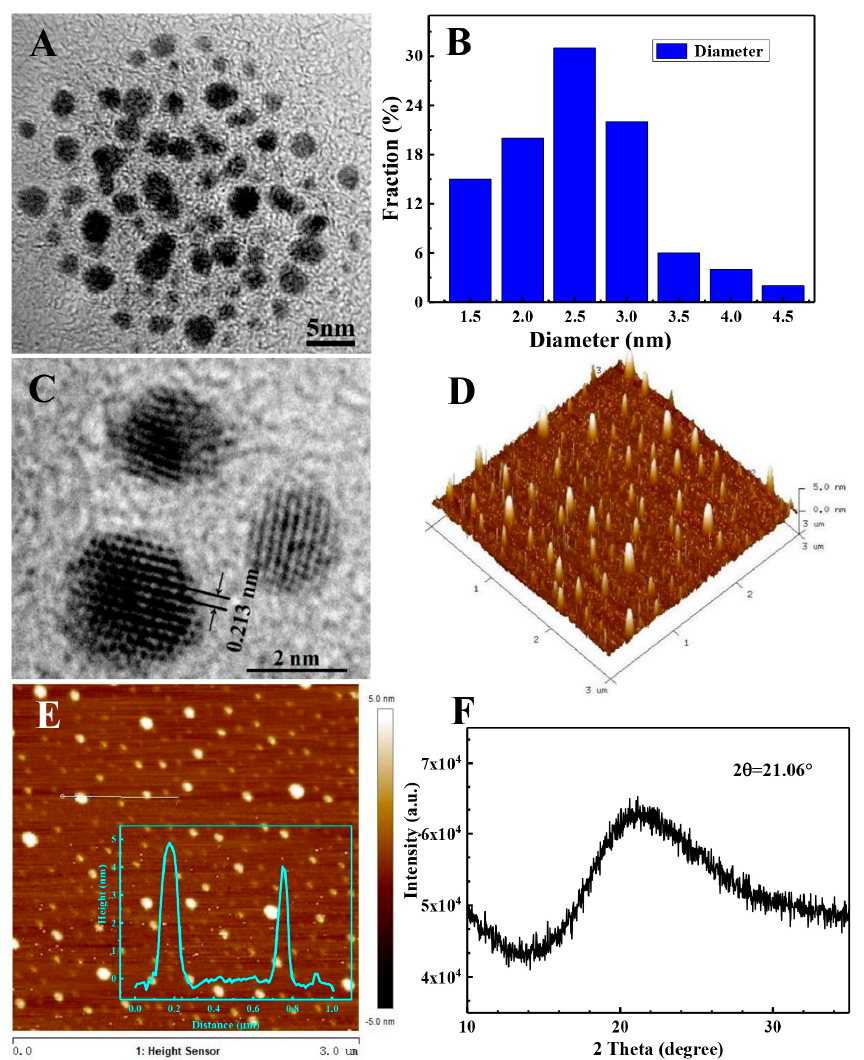
Figure 1. ( A ) TEM, ( B ) size distribution, ( C ) HRTEM, ( D , E ) AFM, and ( F ) XRD pattern of the N- GQDs.